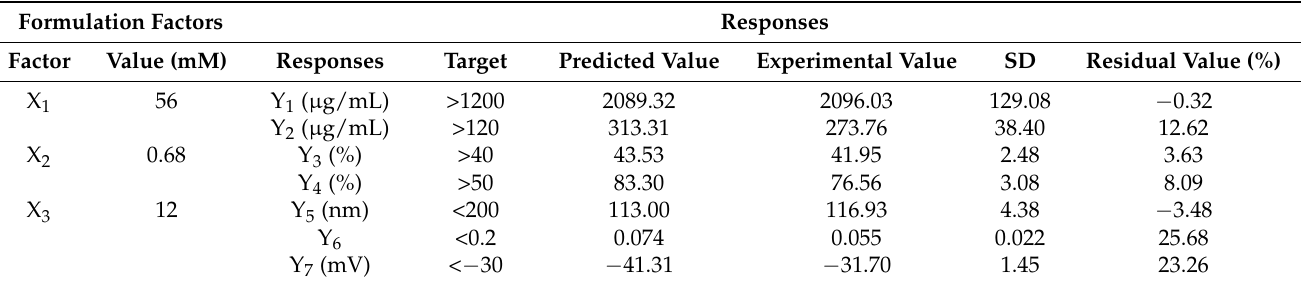
Table 4. The composition of the optimal formulation and its actual physicochemical characteristics vs. predicted ones.